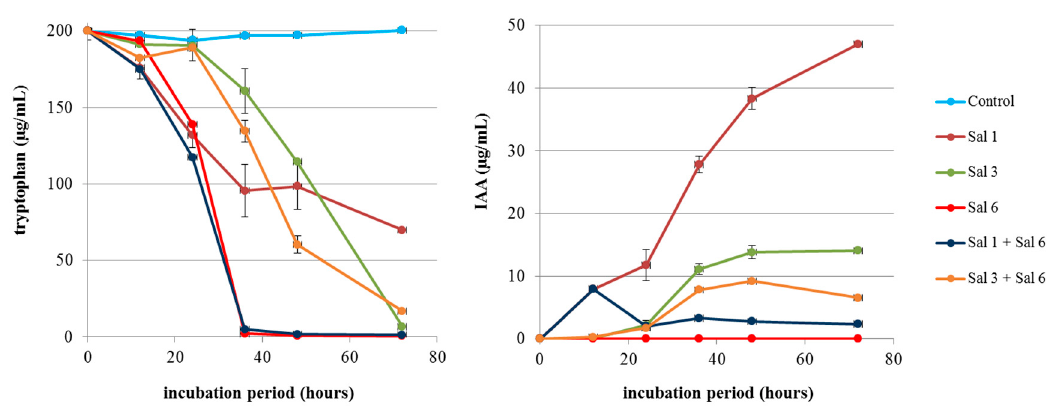
Figure 3. Fate of tryptophan and IAA under co-cultivation of the IAA-producing (Sal 1 and Sal 3) and -degrading (Sal 6) strains of sweet potato endophyte in tryptophan-amended medium. The bars represent the standard deviation (n = 3).